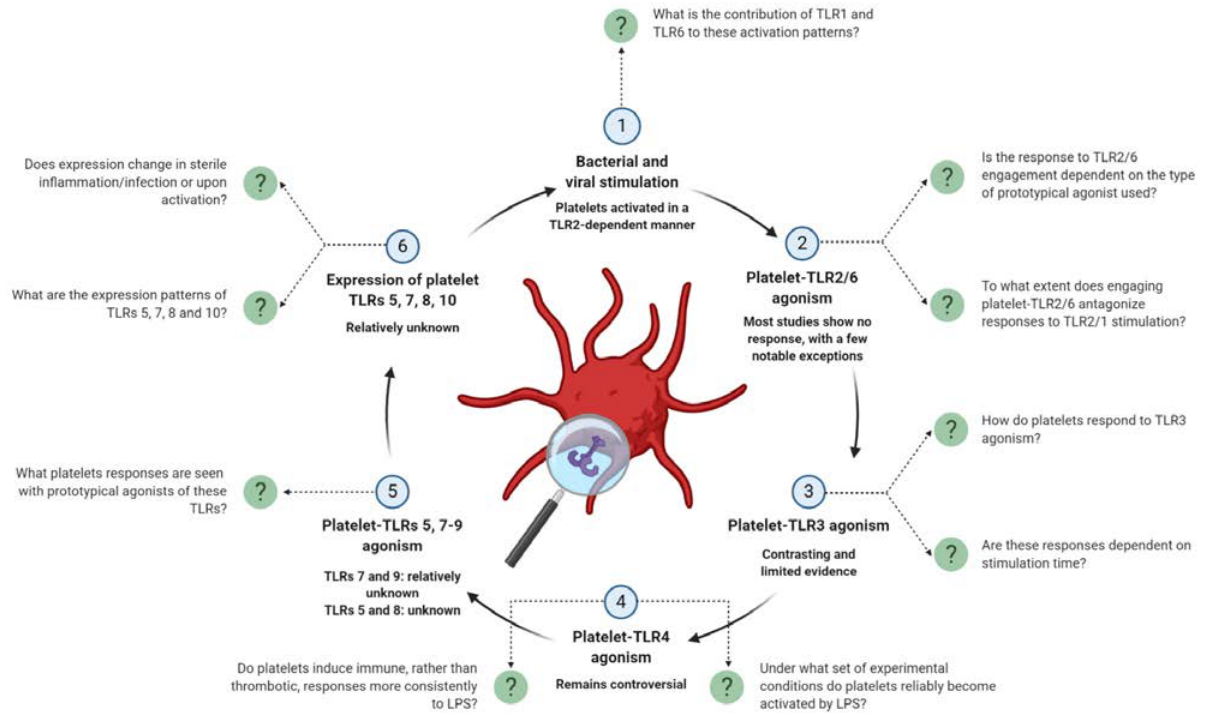
Figure 3. Unanswered questions that remain in the field of platelet-TLR biology.